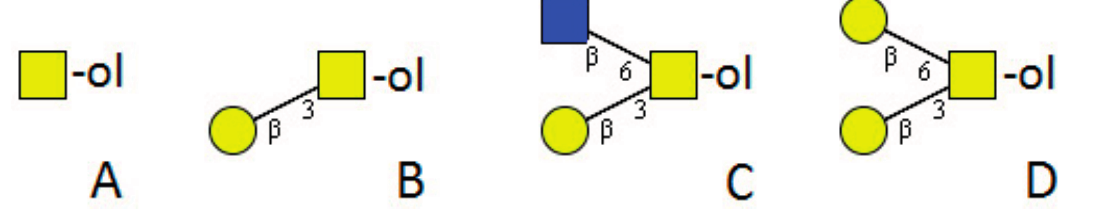
Figure 3. Basic core structures common in invertebrates. ( A ) Tn-antigen; ( B ) T-antigen; core 1 type structure; ( C ) core 2 type structure; ( D ) invertebrate